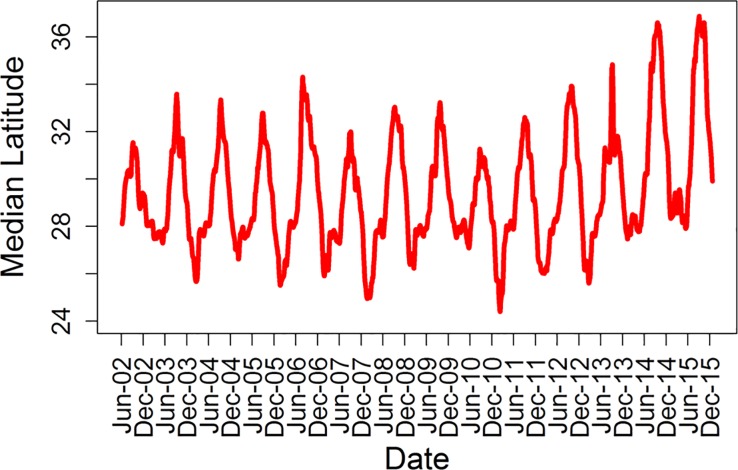
Median suitable latitude over time.The 10-day running mean of the median latitude of the 25% core area used each day. There were significant monthly and yearly differences in the median position. In the summer of 2014 and 2015 there were northerly expanses in median core latitude.